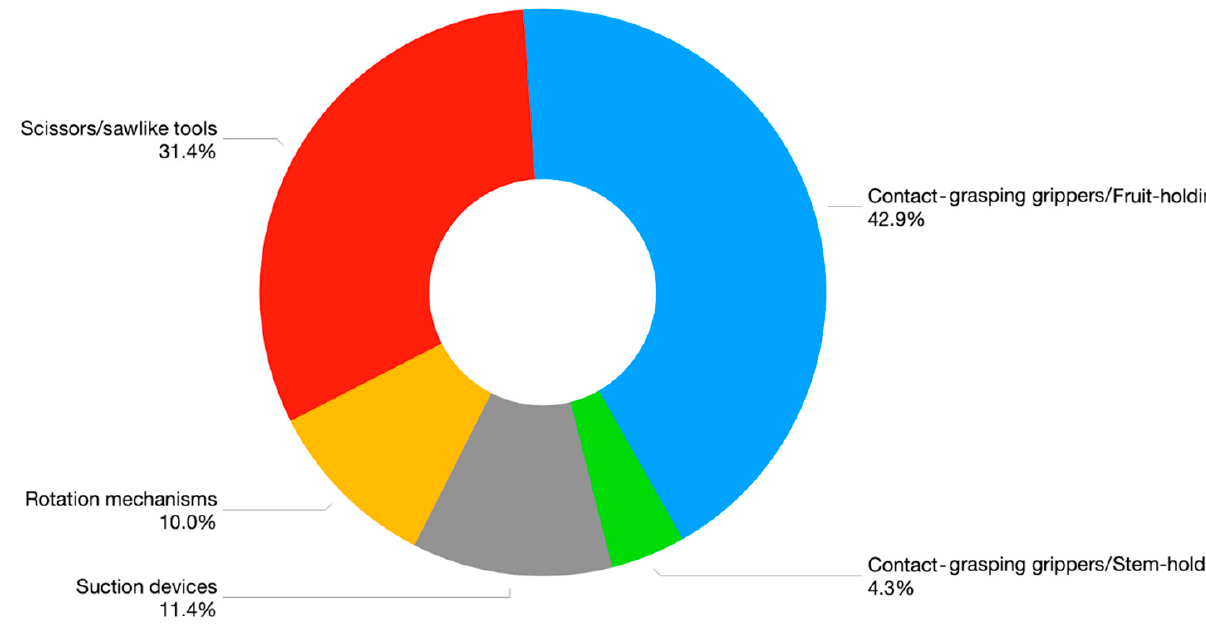
Figure 11. The four end-effector types in the referenced literature: contact-grasping grippers, scis- sor/sawlike tools, rotation mechanisms, and suction devices.